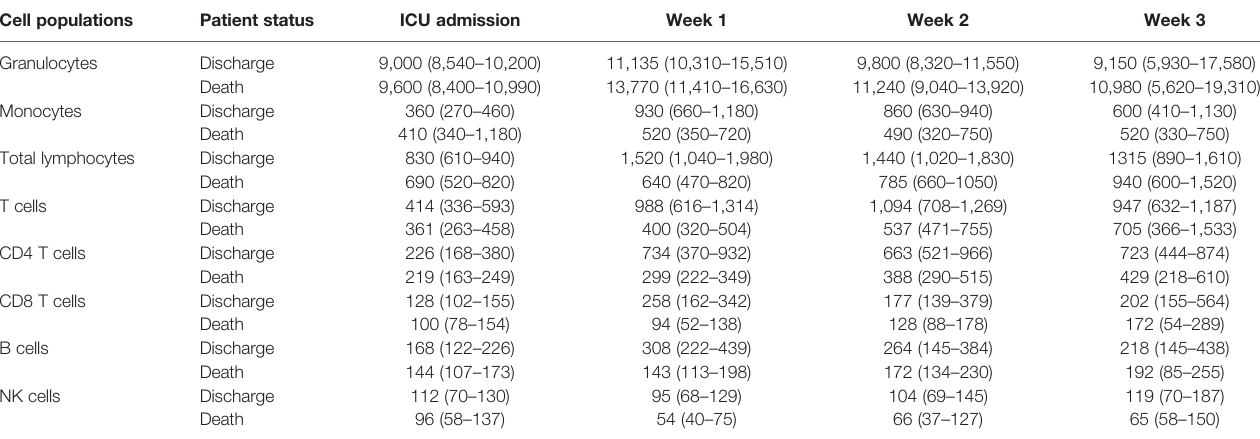
TABLE 3 | Granulocyte, monocyte, and lymphocyte counts during the follow-up of severe COVID-19 patients. Cell